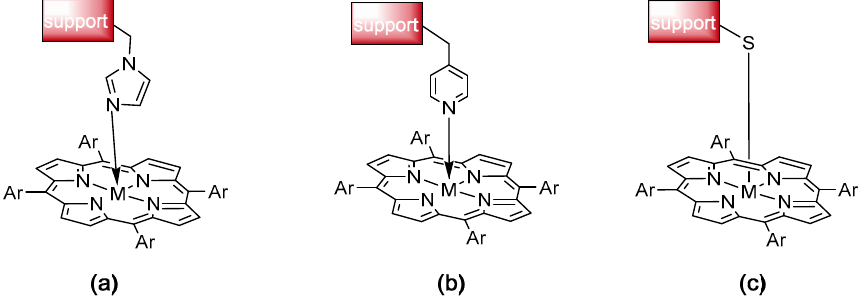
Figure 2. Immobilization of metalloporphyrins through coordination bond. The most common ligands are imidazole ( a ) to emulate the active site of ligninolytic peroxidases [28,143]; pyridine ( b ) [26,31]; and mercapto function ( c ) to emulate the active site of cytochrome P450 and peroxygenase [30].